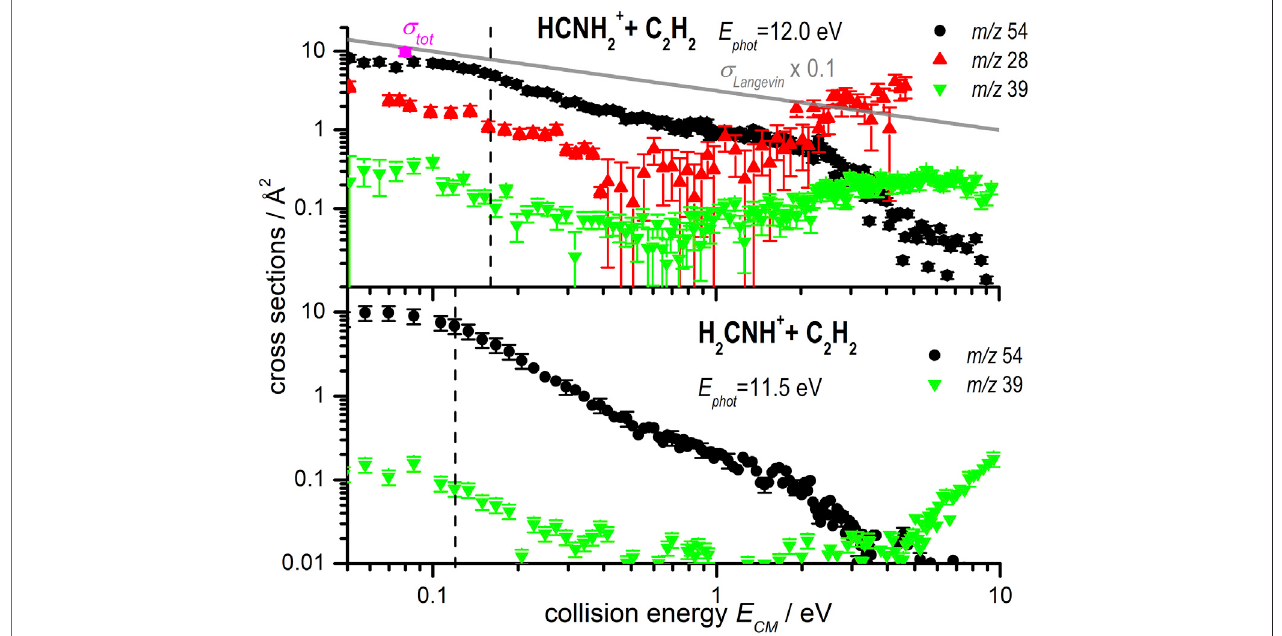
FIGURE 4 | Reactive cross sections as a function of the collision energy ( E CM ) for the reaction of HCNH 2+ (cid:129) (top) and H 2 CNH + (cid:129) (bottom) with C 2 H 2 . The photon energy is fi xed at E phot (cid:2) 12.0 eV (top) and 11.5 eV (bottom) . The vertical dashed lines indicate the collision energy at which data have been collected as a function of E phot (see Figure2 ).Inthetoppanel:thegreysolidlineistheLangevinCS(rescaledbyafactor0.1to fi tinthe fi gure).ThemagentapointisthetotalreactiveCS( σ tot )used to calculate the total rate constant k tot reported in Table 2 .